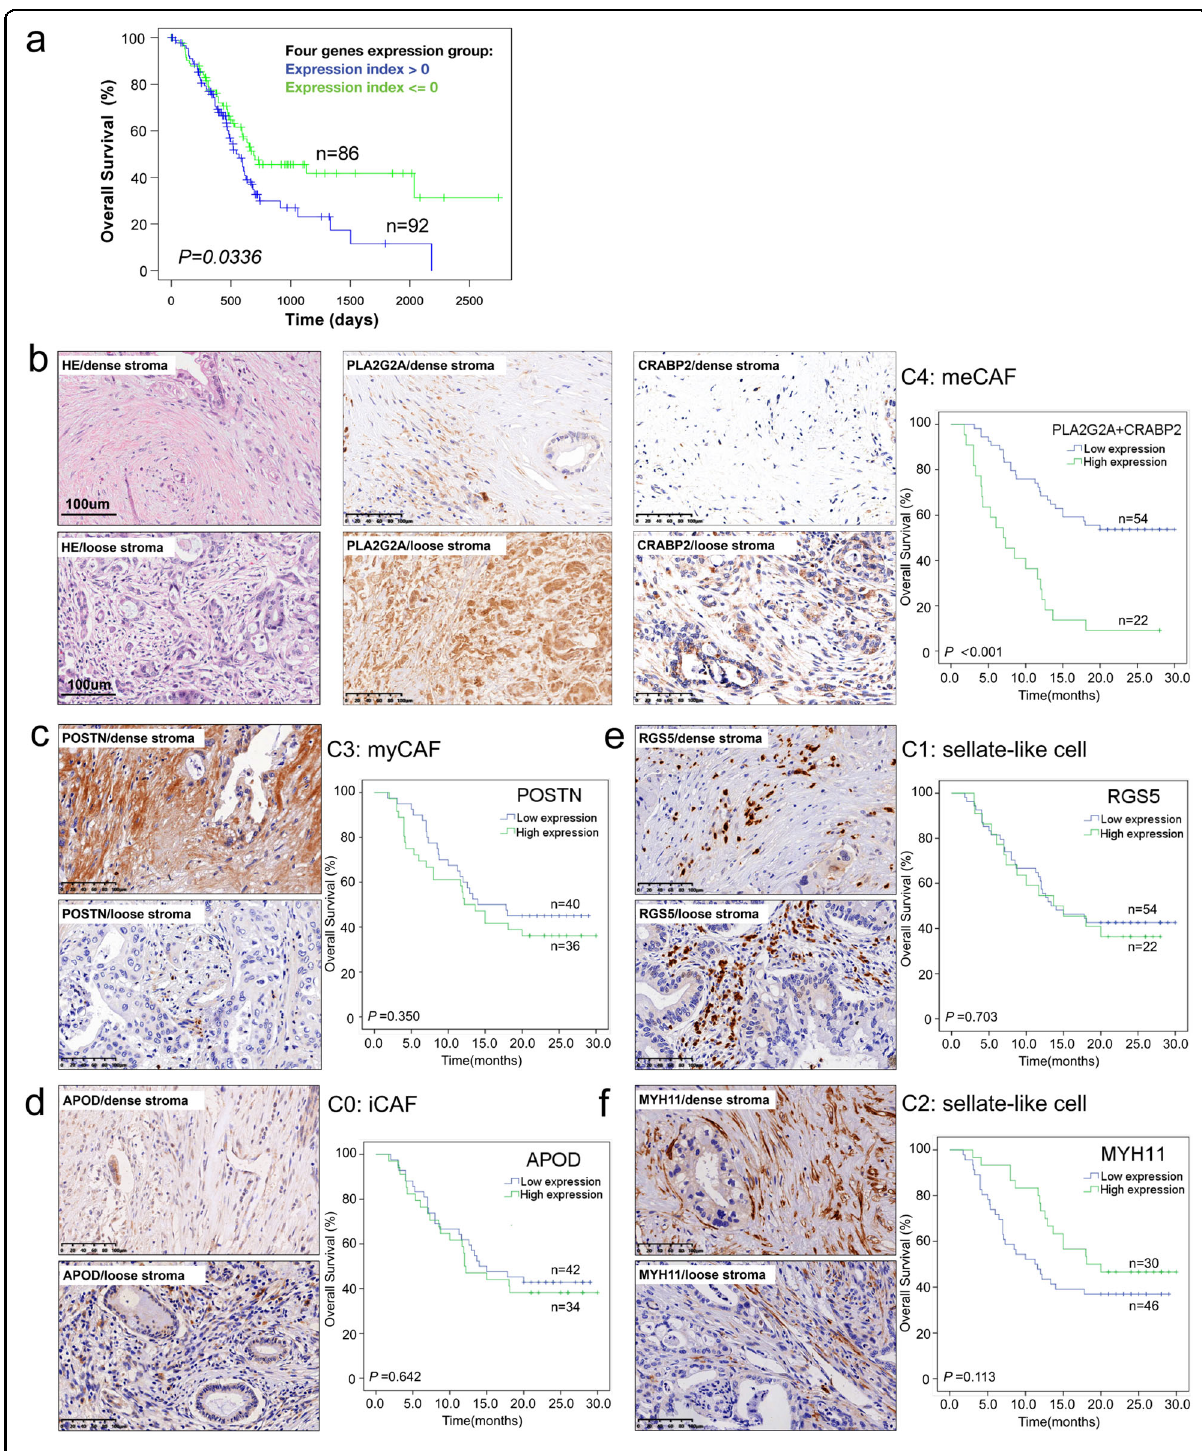
Fig. 4 (See legend on next